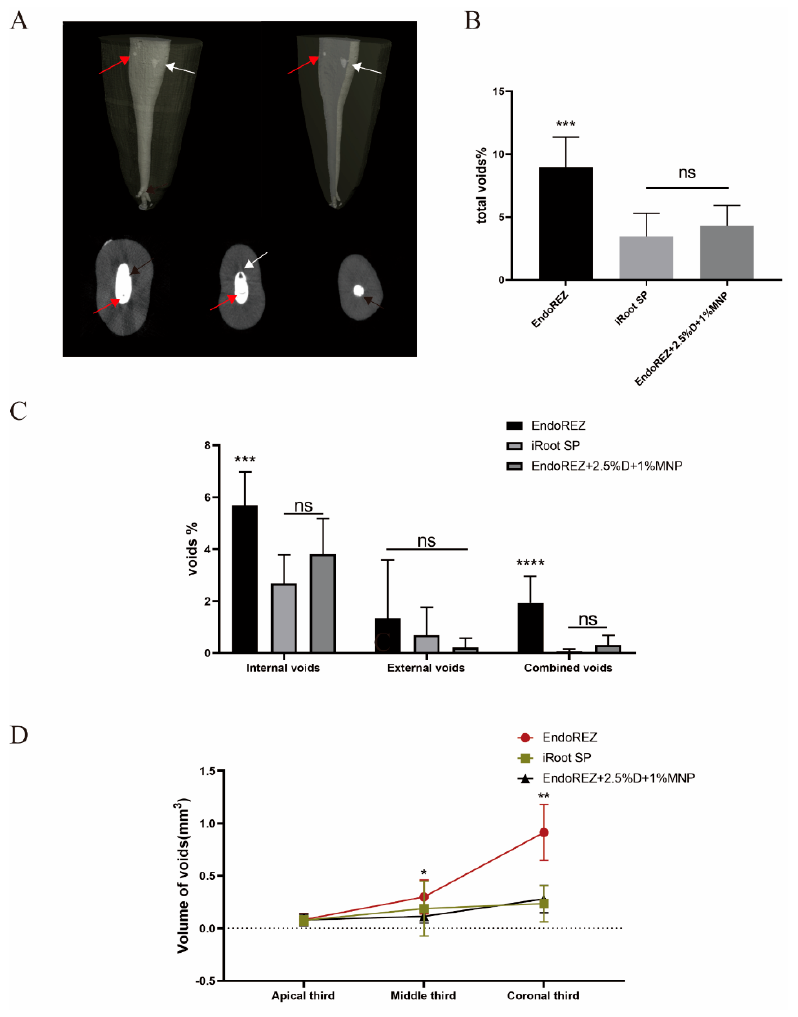
Figure 1. The sealing property of three sealers by micro-CT. ( A ) Two-dimensional slices and three- dimensional reconstruction scanned with micro-CT (voxel size = 13 µ m) show the 3D volumes of voids after the root canal treatment. Black arrows indicate external void, red arrows indicate internal void, and white arrows indicate combined void. ( B ) The total void fraction in the whole root canal filling materials. ( C ) The void fraction (internal, external, and combined) in the whole root canal filling materials. ( D ) The void volumes (apical, middle, coronal thirds). Every value is shown as mean ± SD ( n = 10); * p < 0.05, ** p < 0.01, *** p < 0.001, **** p < 0.0001, ns p > 0.05. Figure 1D details the percentage of void volume in the apical, middle, and coronal thirds. The voids of the modified root canal sealer in the middle and coronal thirds were 0.115 ± 0.063 and 0.280 ± 0.131 mm 3 , lower than EndoREZ’s 0.300 ± 0.162